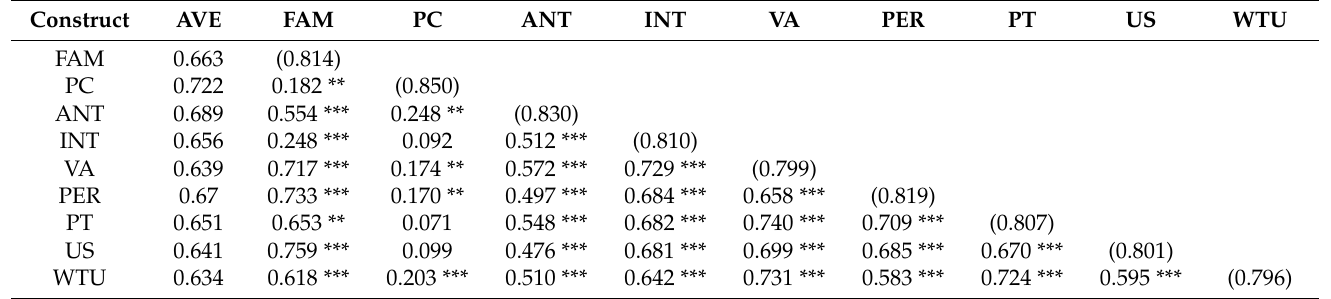
Table 4. Correlation matrix of the